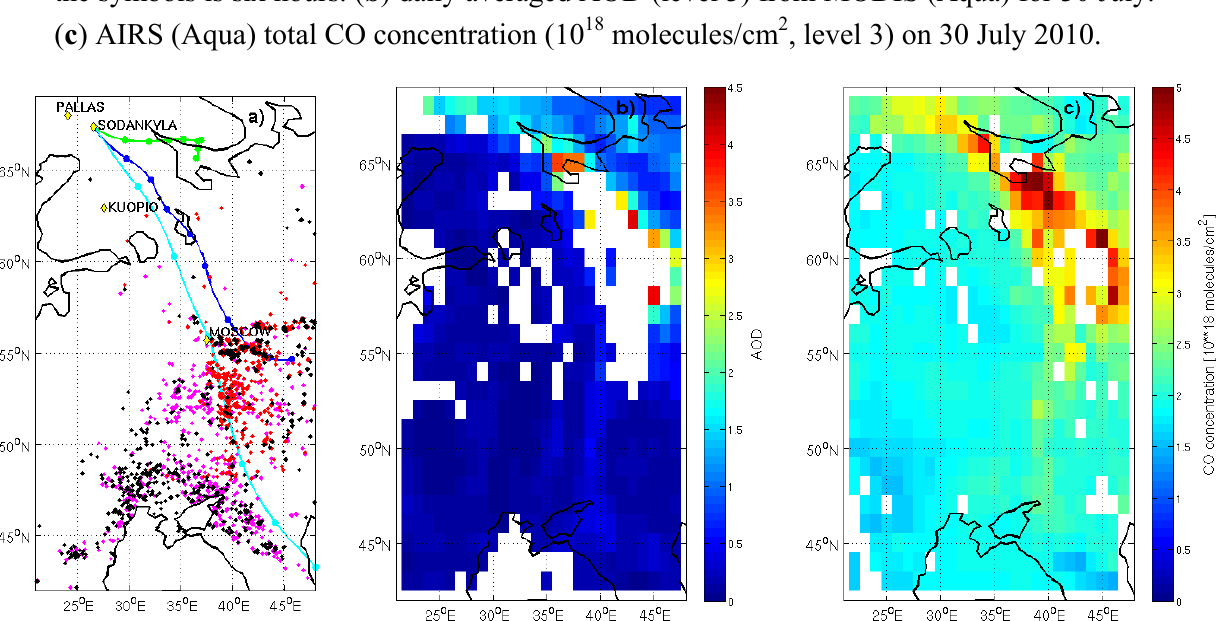
Figure 1. ( a ) air mass trajectories at three levels (500 m ASL (green), 1,000 m (blue), 3,000 m (magenta)) for 30 July and the fires detected by MODIS on 28 July (yellow), 29 July (red) and 30 July (black). The trajectories are for 48 h and the time difference between the symbols is six hours. ( b ) daily averaged AOD (level 3) from MODIS (Aqua) for 30